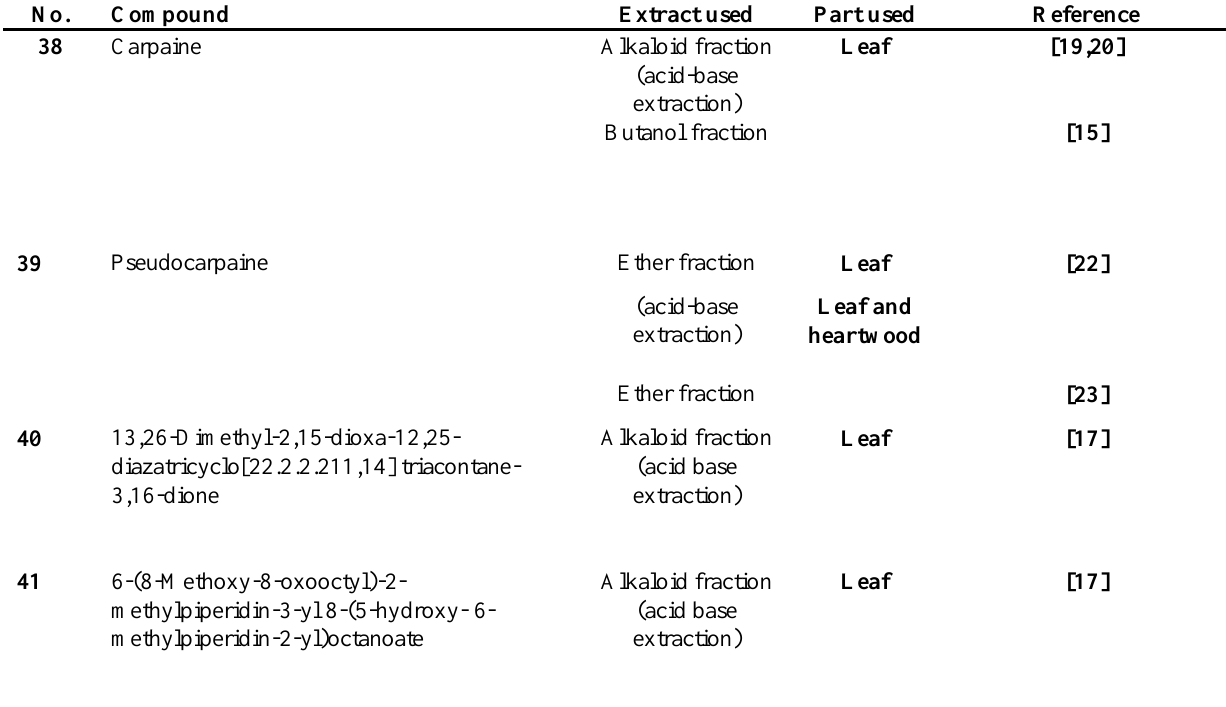
Table 4. Alkaloids reported in C.